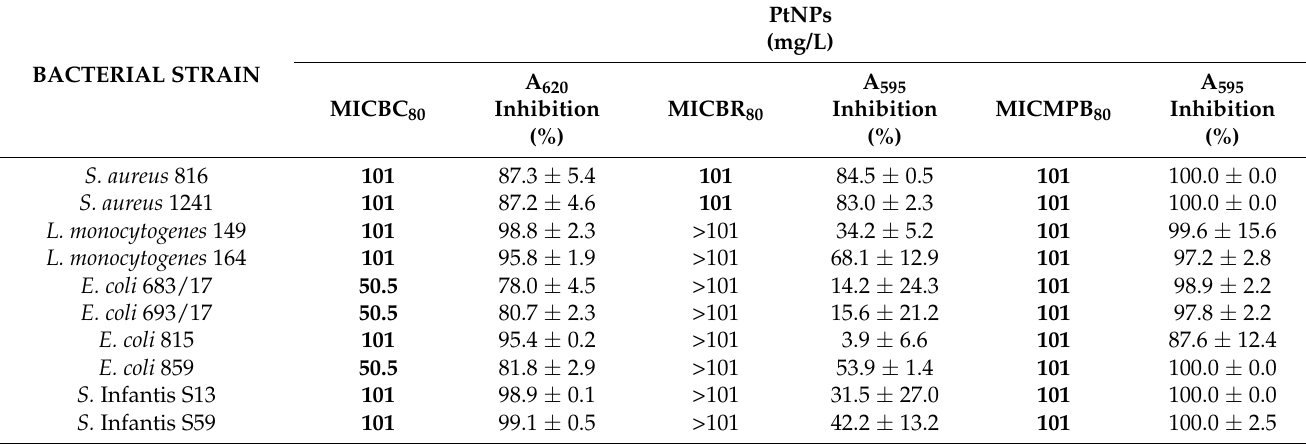
Table 4. Minimal concentrations inhibiting further growth of biofilm cells, biofilm reduction and biofilm metabolic activity with their respective inhibitory rates of PtNPs for biofilms. Data represent the mean of at least three independent replicates. The significance of the results was verified by t -test ( p ≤ 0.05).